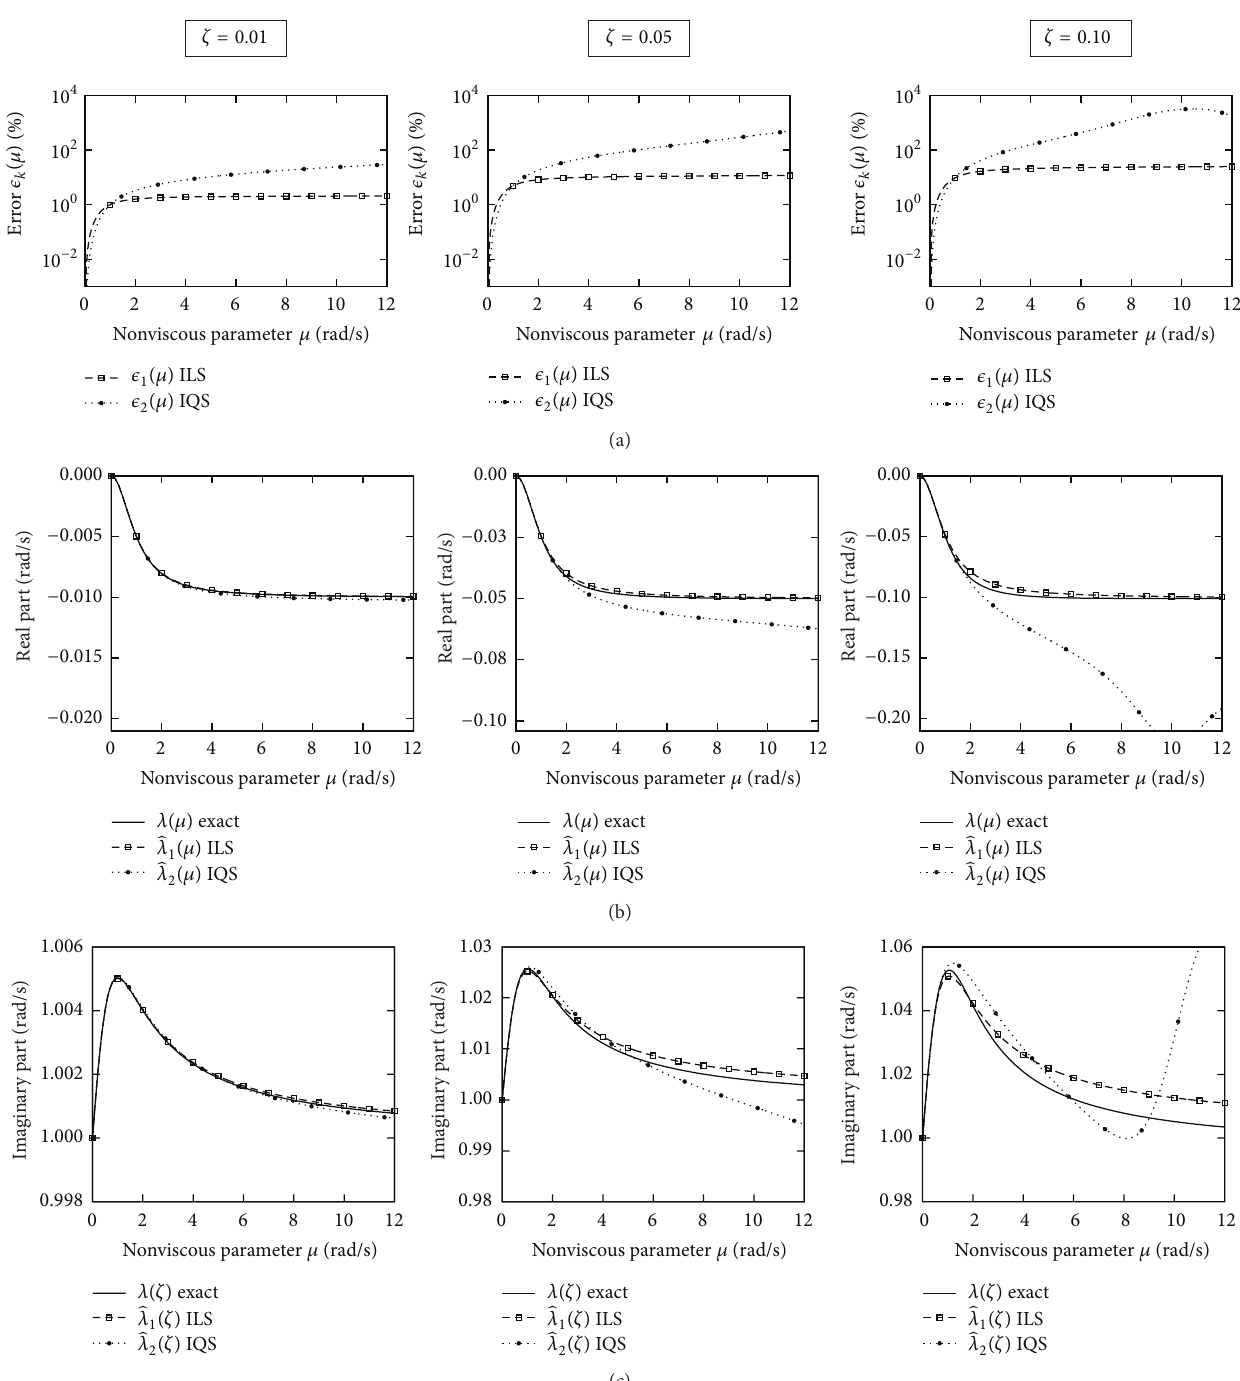
Figure 3: Case 𝜃 = 𝜇 . Relative error 𝜖 𝑘 (𝜇) = |Ψ−𝜓 𝑘 |/|Ψ| of the integrand function (a). Eigenvalues versus parameter 𝜇 (b and c). Continuous line for exact values and dotted one for Improved Solutions: square tick for Linear (ILS) and bullet for Quadratic (IQS).